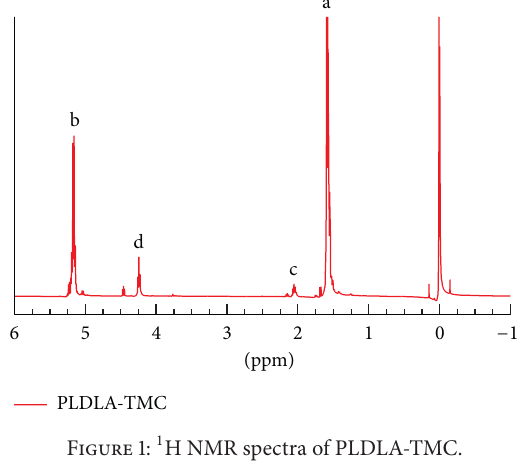
Figure 1: 1 H NMR spectra of PLDLA-TMC.